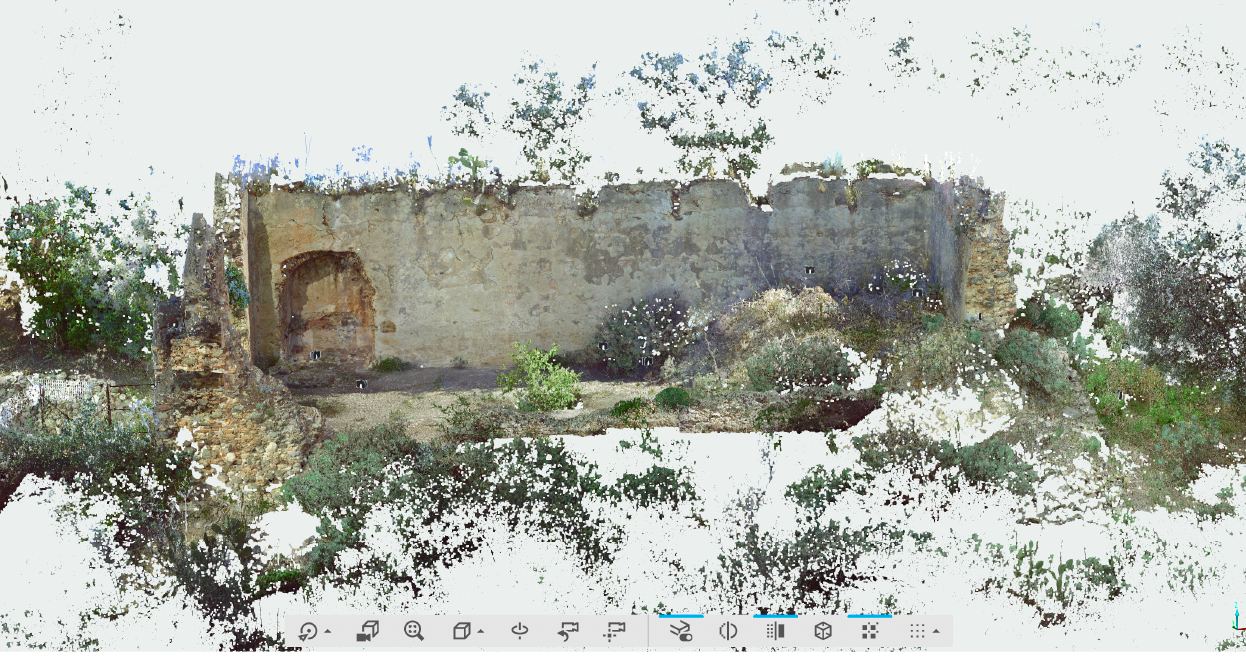
Figure 12. Church of San Basilio: interior of aisle wall.